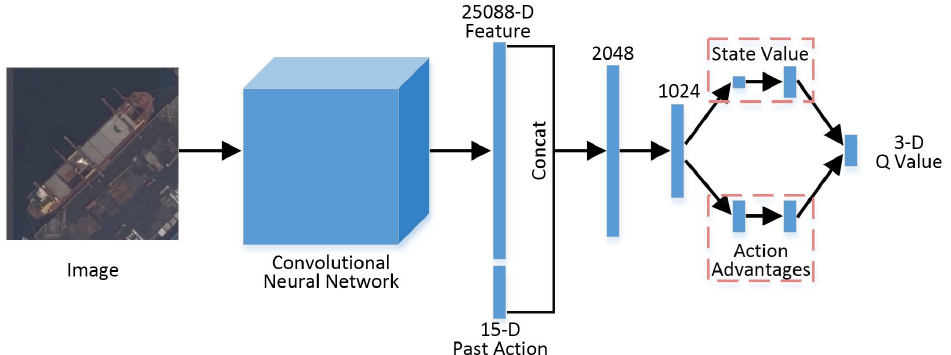
Figure 8. The dueling network of angle prediction. The state value and action advantages are estimated in parallel structure of dueling